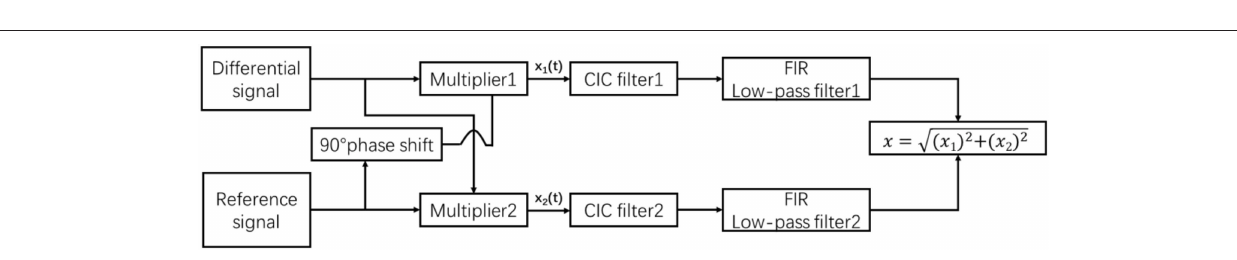
FIGURE 6 | The structure of the digital lock-in amplifier